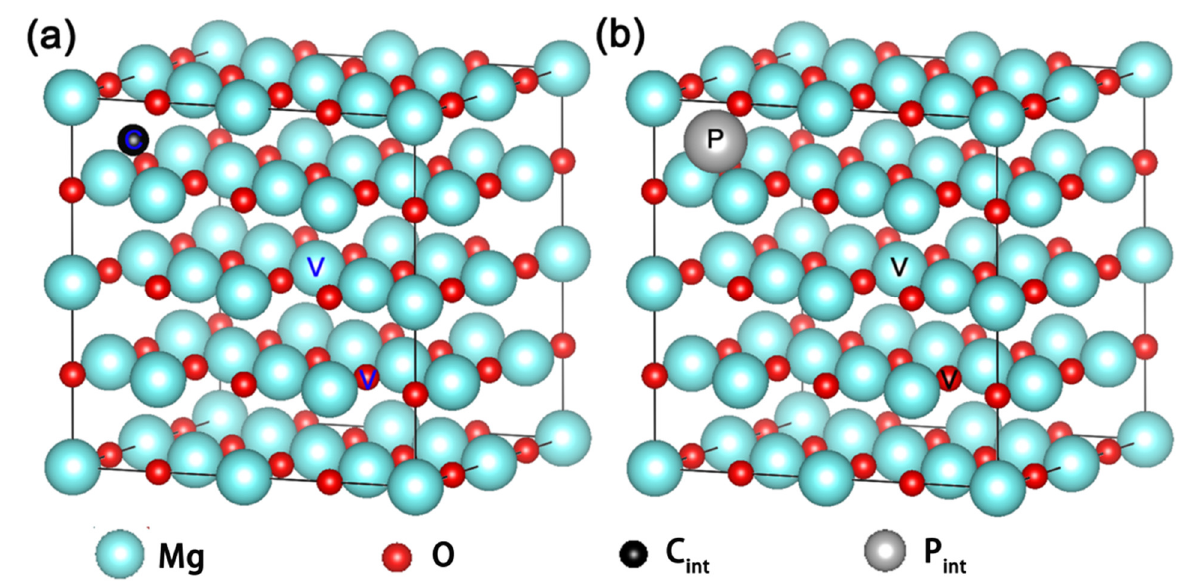
Figure 6. ( a ) The position of V Mg (C Mg ), V O (C O ), and C int for the C-implanted MgO system. ( b ) The position of V Mg (P Mg ), V O (Po), and P int for the P-implanted system. V represents the Mg vacancy or O vacancy. The C Mg and P Mg are located at the same position with V Mg , the C O and P O are located at the same position with V O . the same position with V O